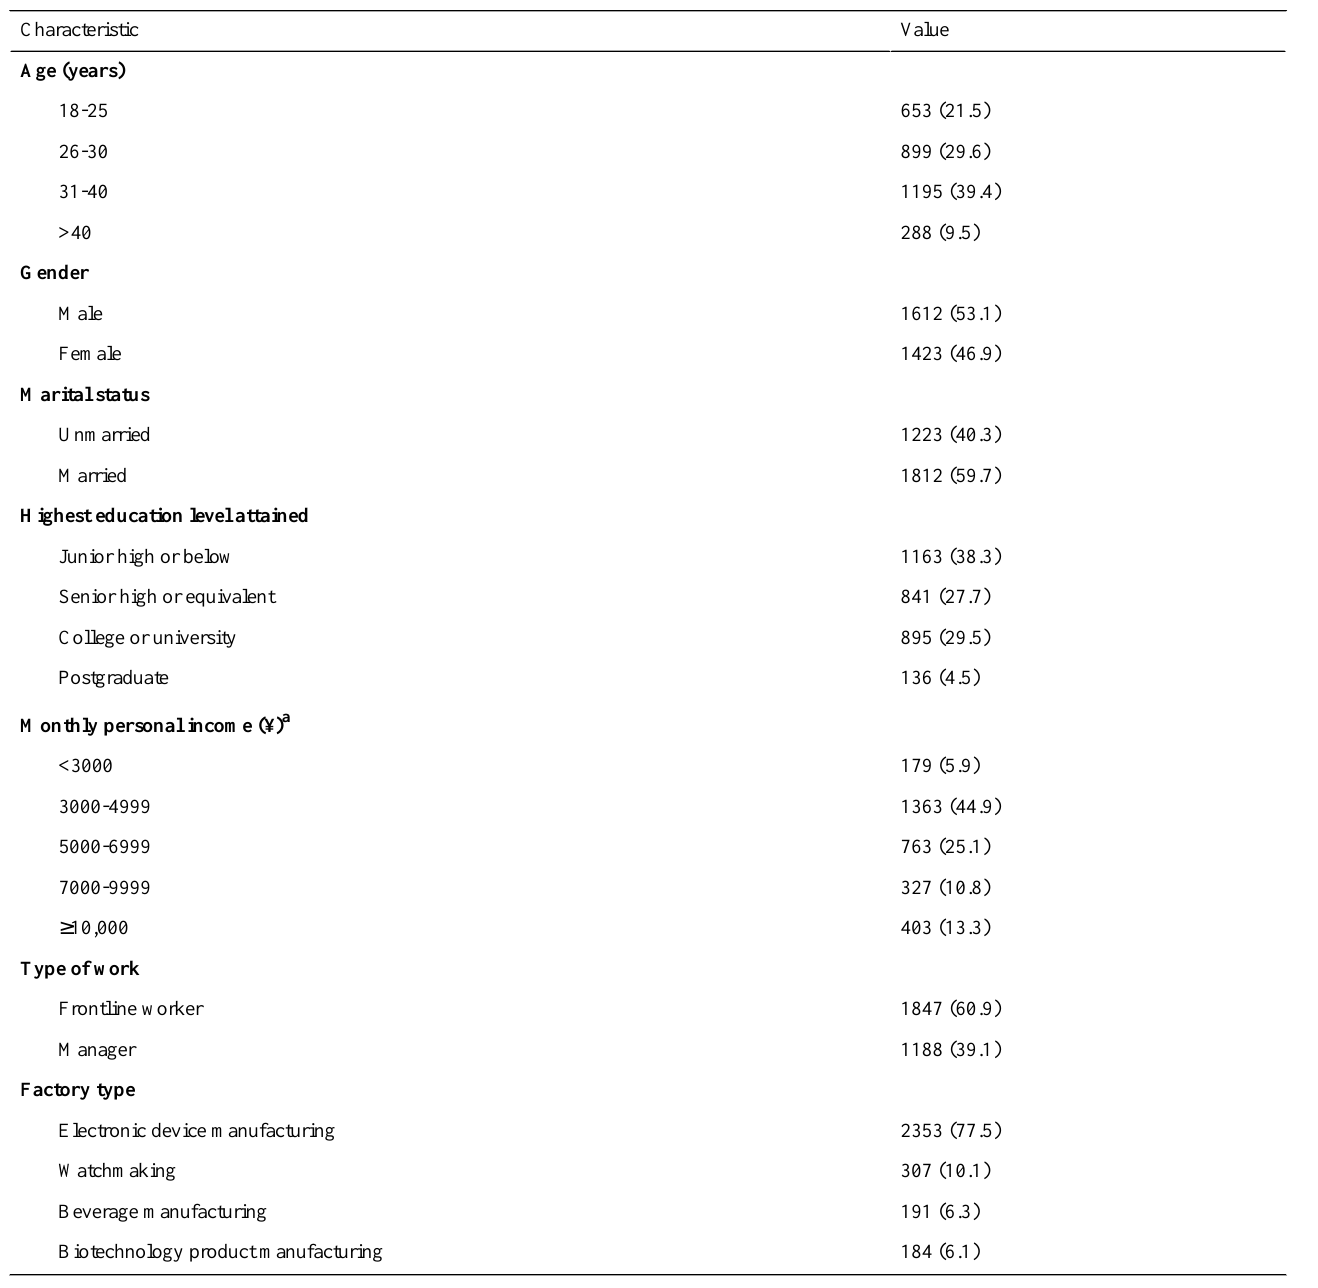
Table 1. Background characteristics of the study sample (N=3035), n